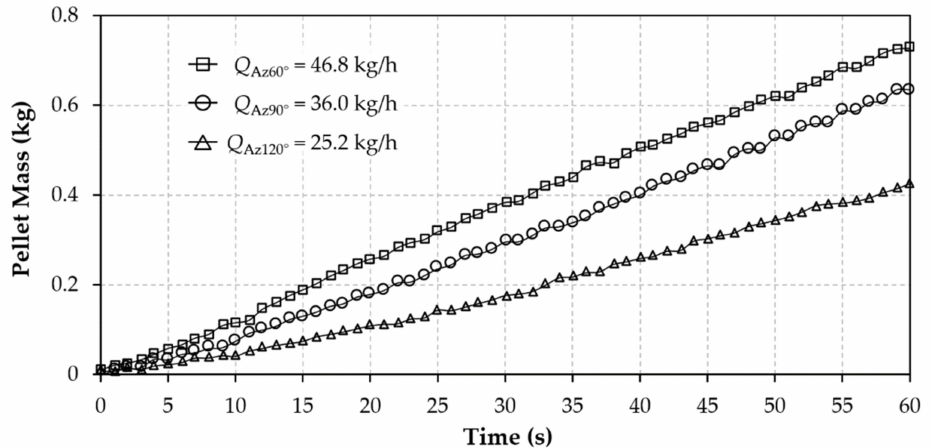
Figure 7. Cumulative weight of cooled pellets in time and mass flow rate Q (kg · s − 1 ) depending on eccentric weight adjustment.